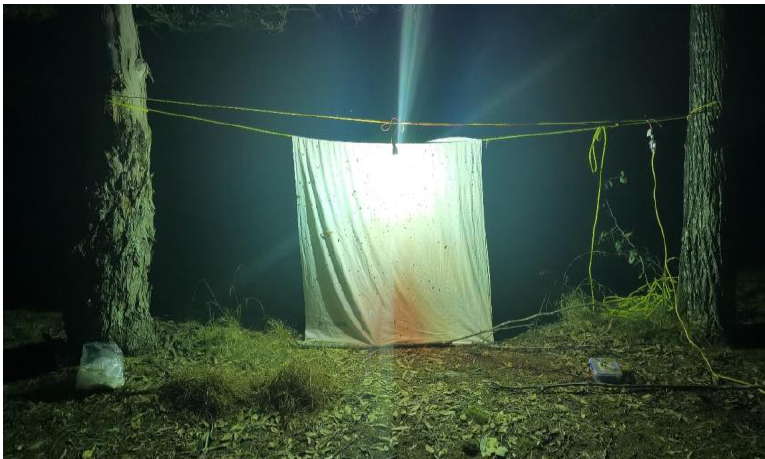
Figure 1. Light trap set during field collection.